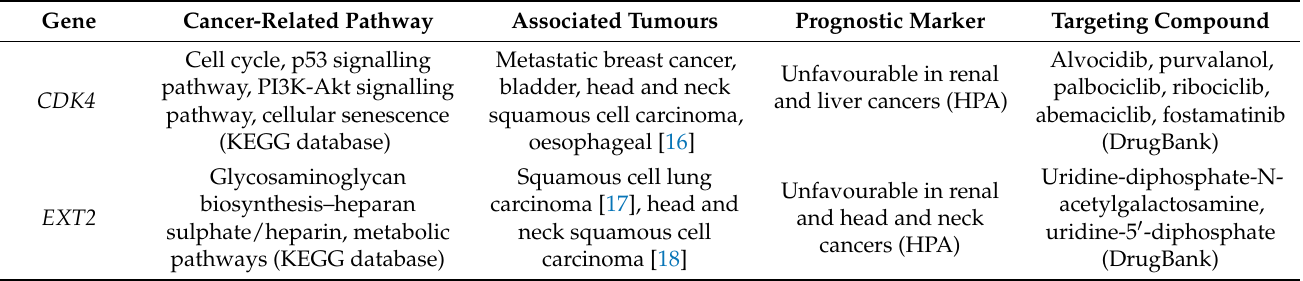
Table 4. Selection of genes involved in copy number gains after consulting the literature and databases (The Kyoto Encyclopedia of Genes and Genomes database—KEGG database, Human Protein Atlas - HPA, and